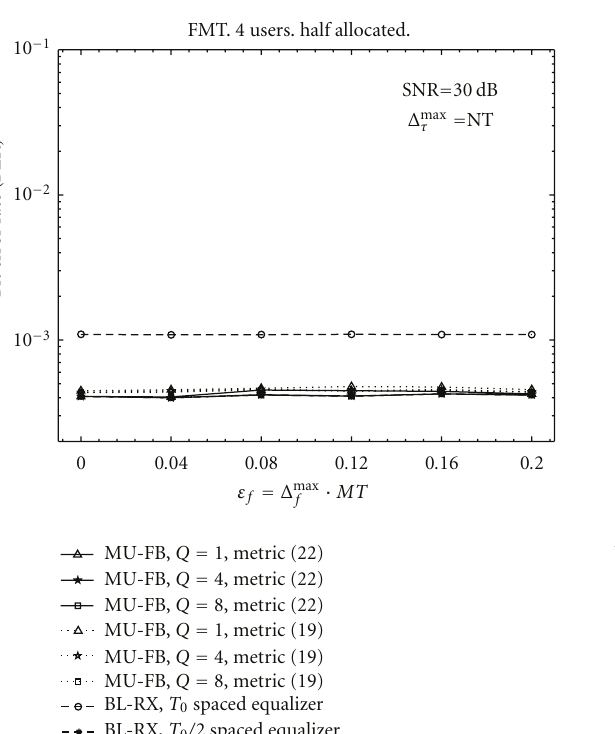
Figure 6: BER as a function of frequency o ff set. 8 interleaved users with only 4 nonadjacent active users. Comparison of the compensation metrics for di ff erent values of Q. OFDM with M = 32 and CP = 8